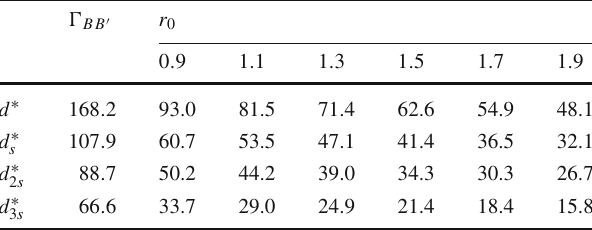
Table 4 Decay widths (in MeV) of d ∗ ( 2380 ) and its flavor SU(3) part- ners at selected values for the distances (in fm) of two diquarks. (cid:2) BB (cid:7) is the decay width of a bound BB (cid:7)